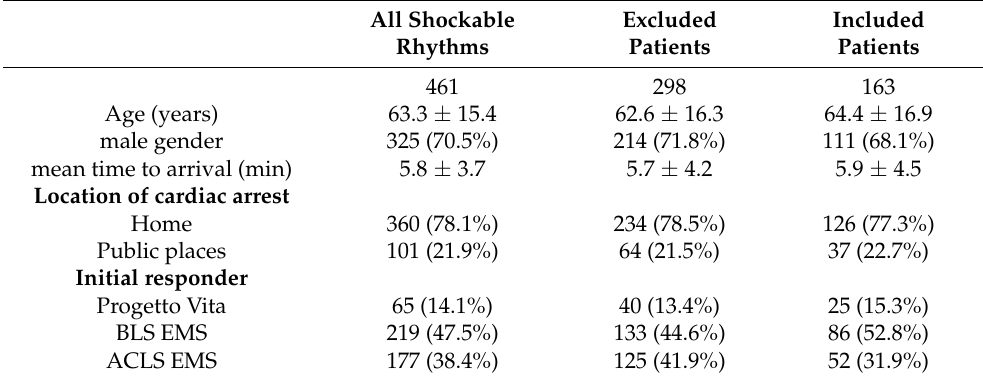
Table 1. General characteristics of all patients presenting with a shockable rhythm, divided according to the availability of good-quality